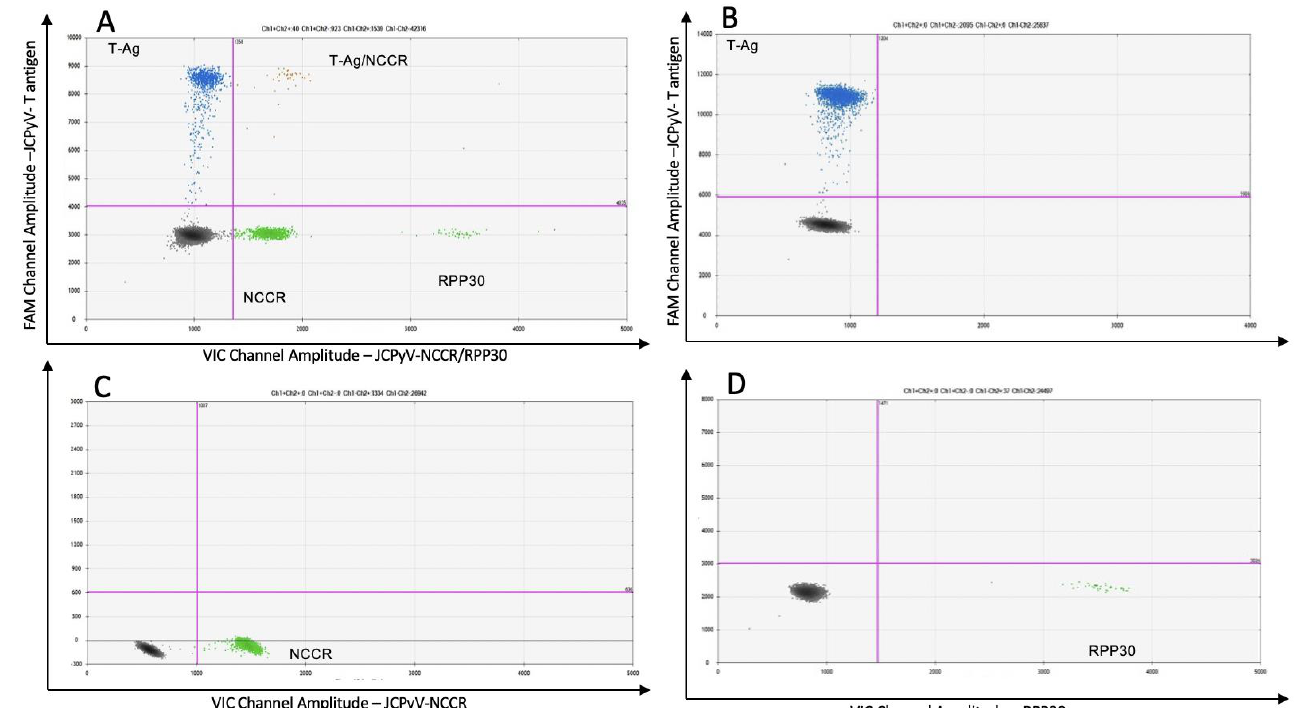
Figure 5. Representative plots of triplex and singleplex ddPCR of a CSF sample from a PML patient. ( A ) Triplex for JCPyV large T antigen, JCPyV-NCCR for the archetype variant and RPP30, housekeeping gene. Population double positive for T antigen and NCCR is in the upper right quadrant. ( B ) The FAM channel is on the y-axe, and the droplet population in the upper left quadrant reflects a positive detection of the Large T antigen coding region. ( C ) The VIC channel is on the x-axe detecting the unique sequence of the NCCR of the non-pathological JCPyV variant, and the droplet population in the lower right quadrant indicates a positive detection of this sequence. ( D ) The VIC channel targeting the house-keeping gene RPP30 is on the x-axe, and the positive droplet population in the lower right quadrant.